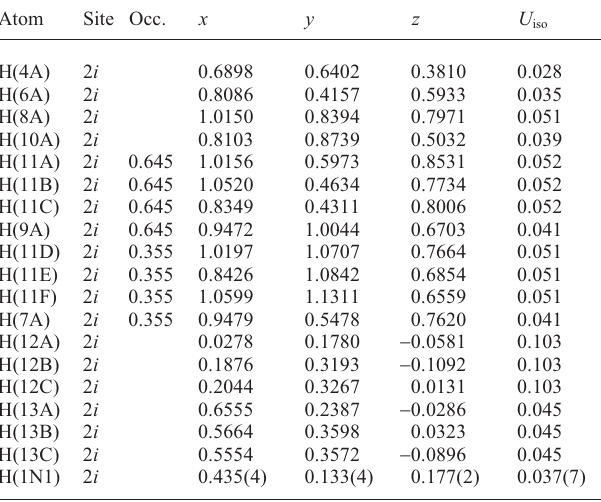
Table 2. Atomic coordinates and displacement parameters (in Å 2 ) . Atom Site